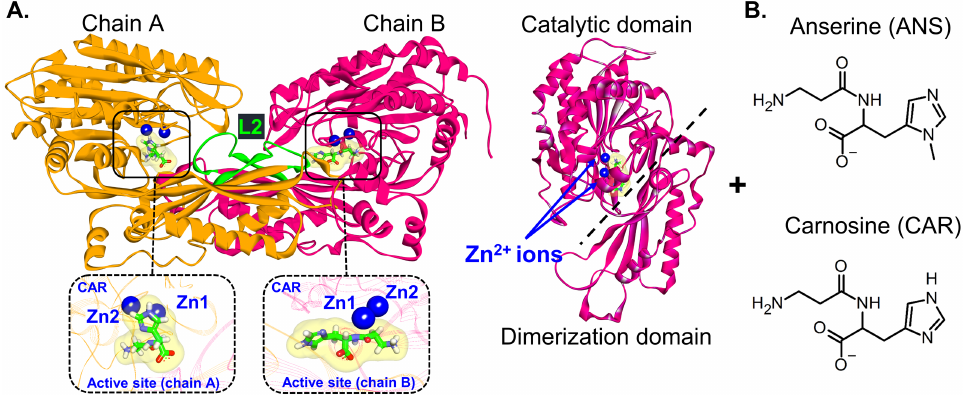
Figure 1 CN1 structure. (A) Structure of Zn 2 + -containing carnosinase 1 (CN1) homodimer. Bound carnosine and anserine with two Zn 2 + ions in the binding site are shown in the insets. The catalytic and dimerization domains are displayed on the right. The latching loops (L2) are labelled in green (residues 324–341). Chemical structures of carnosine (CAR) and anserine (ANS) are shown in (B). Full-size DOI: